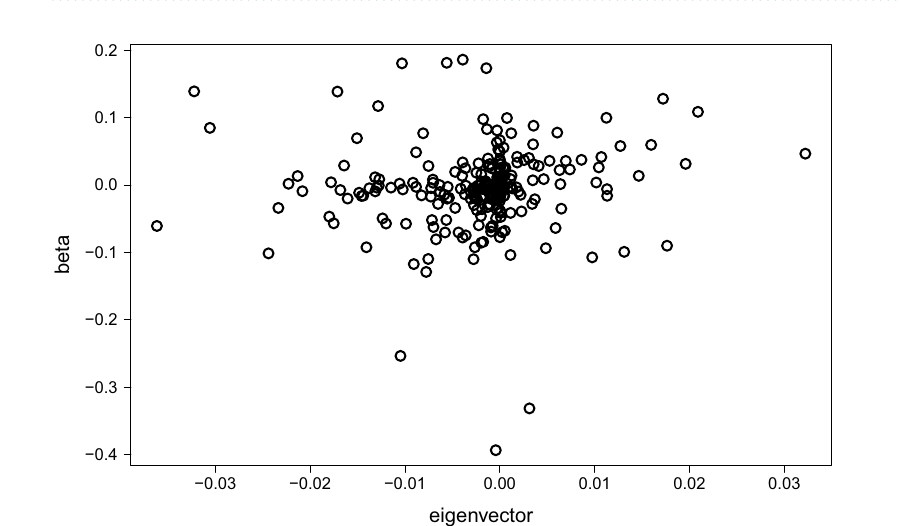
2 Figure 5. Box and whisker plot of R . The variance-covariance matrix used in the simulations is (cid:31) 1 in ( a , b ), (cid:31) 2 in ( c , d ), and (cid:31) 3 in ( e , f ). The regression model is estimated by the lasso in ( a ), ( c ), and ( e ) and by PCR in ( b ), ( d ), and ( f ).